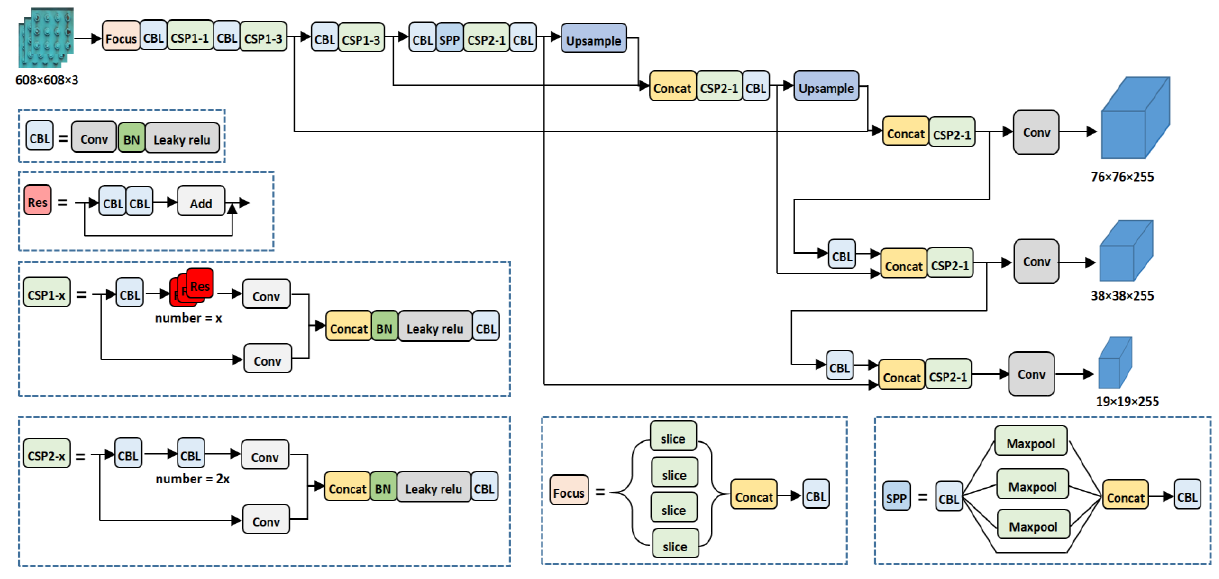
Figure 8. Network structure of YOLO v5s.